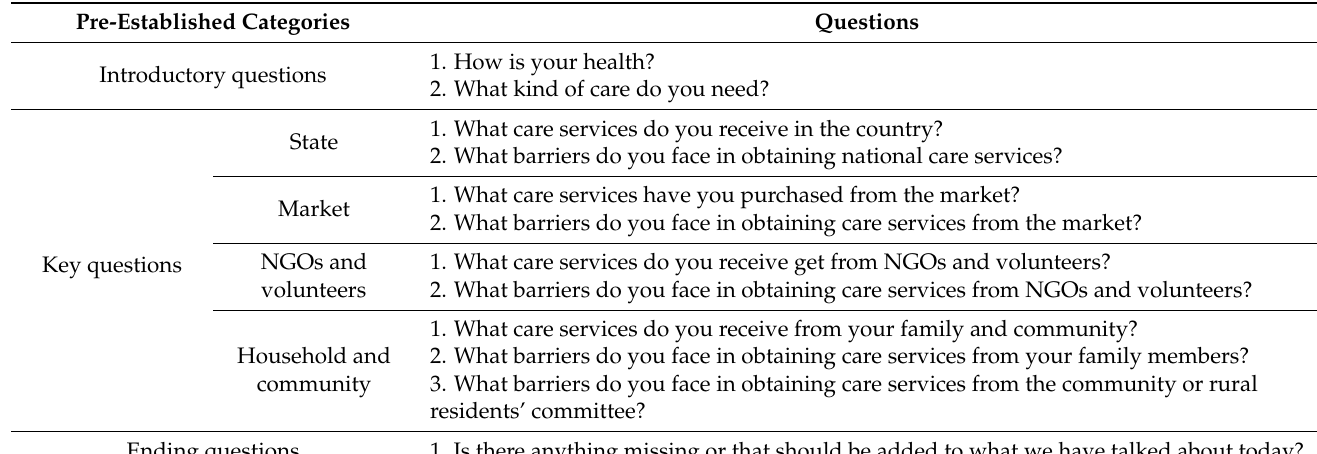
Table 2. Semi-structured interview